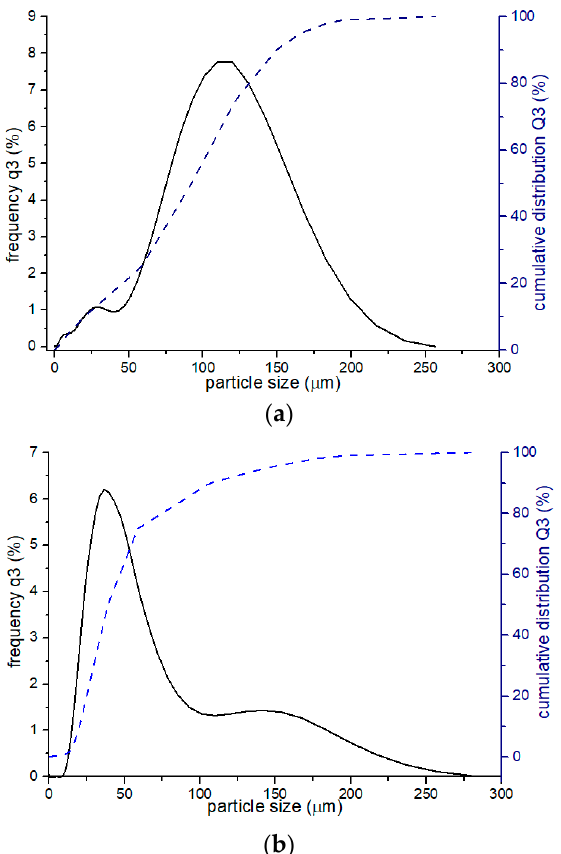
Figure 4. Granulometric analysis of the powders after ( a ) 1 h and ( b ) 90 h of MA. Table 2. Summary of statistical parameters for tested powders.